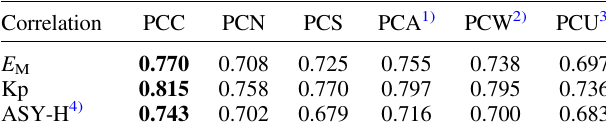
Table 5. Correlation coef fi cients for epoch 1998 – 2018 (ex. 2003 and 2013). The PCC correlation values are